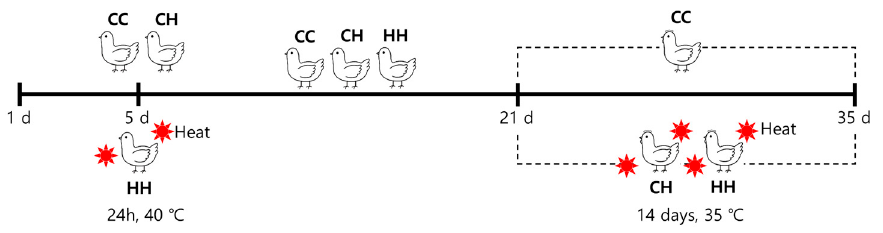
Figure 1. Schematized schedule of heat exposure condition. CC: raised at a suitable temperature without heat exposure. CH: chronic heat exposed group. HH: early and chronic heat exposed group.